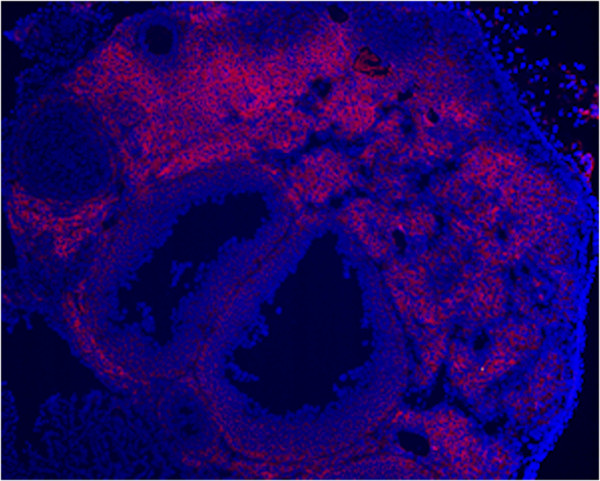
Notch2 (red) in developing follicles. Intense staining in secondary follicles and sporadic red staining in tertiary follicles with complete absence of staining in the peripheral theca layer of the depicted 2 large follicles (10× magnification, DAPI counterstaining in blue).